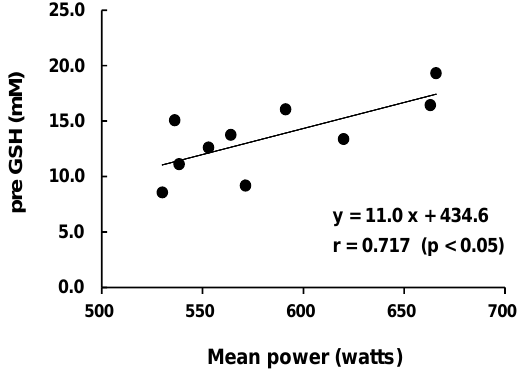
Figure 3. The relationship between mean power and singlet oxygen scavenging activity pre-exercise. A significant correlation between the mean power and singlet oxygen scavenging activity before exercise was observed (r = 0.717, p = 0.02).